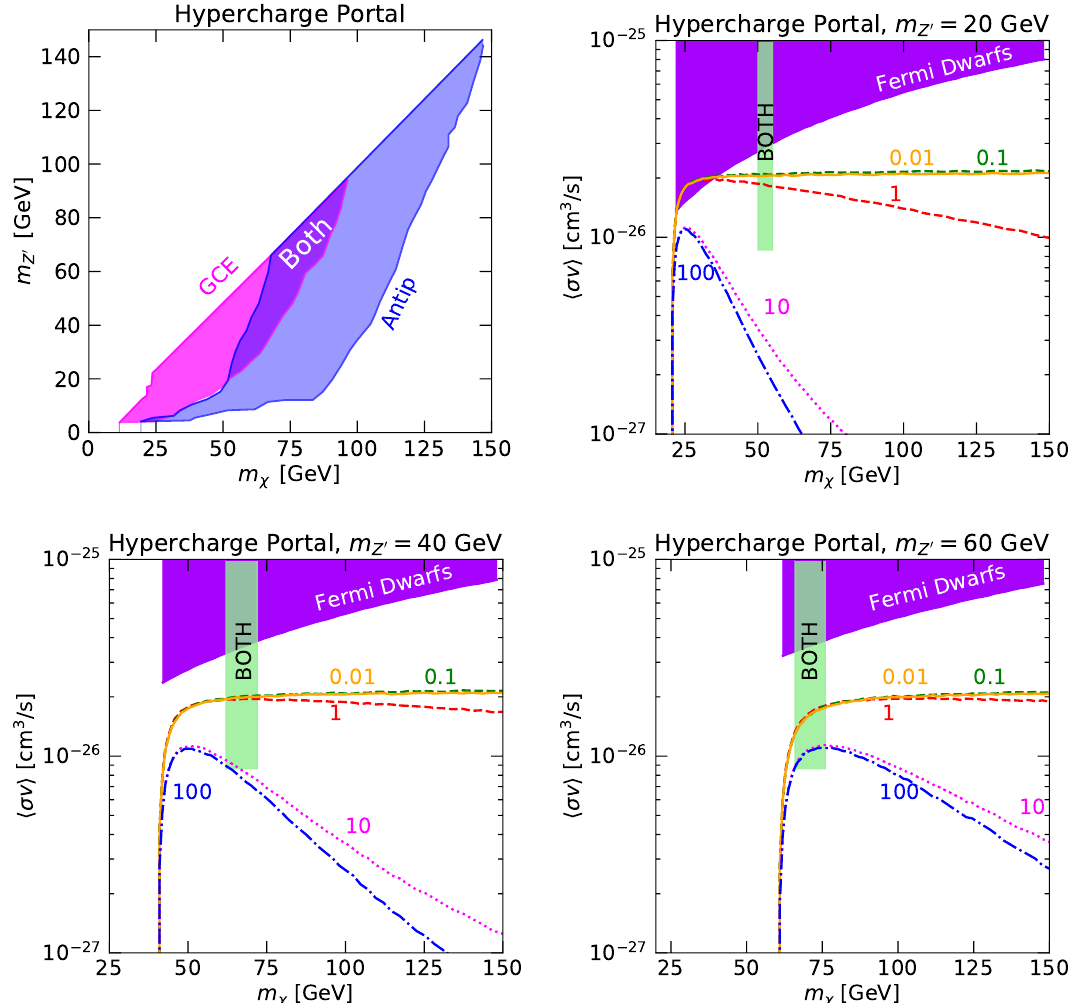
Figure 5 . A summary of our results for the case of hidden sector dark matter that annihilates to particles that decay through the hypercharge portal. In the upper left frame, we show the regions of the m (cid:31) - m Z 0 plane that can produce the observed spectrum and intensity of the Galactic Center gamma-ray excess (GCE), the cosmic-ray antiproton excess (Antip), or both. In the remaining three frames, we plot the low-velocity, thermally-averaged annihilation cross section predicted in this model, for three representative values of m Z 0 . Each line corresponds to a di(cid:11)erent ratio of the vector and axial couplings, (cid:21) v =(cid:21) a . The green shaded regions labeled \BOTH" denote the parameter space in which both excesses can be simultaneously accommodated. We also show the regions ruled out by gamma-ray observations of dwarf galaxies.